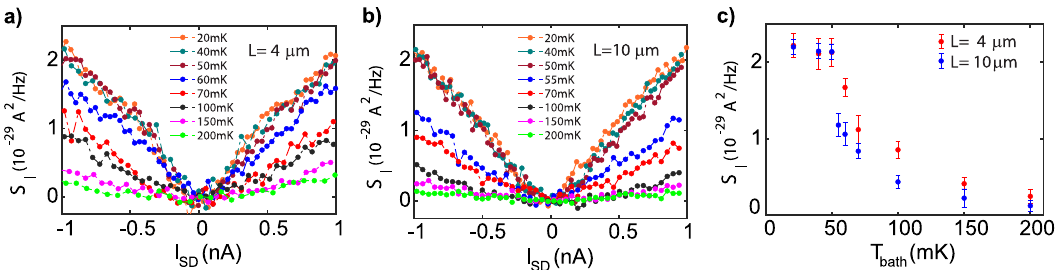
Fig. 3 Temperature dependence of the noise. a and b show the noise along the upstream direction at ν = 2/3, at different bath temperatures for L = 4 μ m and L = 10 μ m, respectively. c Noise value at I SD = 1 nA, extracted from the averaged slopes (positive and negative bias) of the linear fi ttings of the noise data (Fig. 3a and b), is plotted as a function of bath temperature for 4 μ m (red circles) and 10 μ m (blue circles) for ν = 2/3. The error bar here is the standard deviation in averaged slope of the linear fi t. The linear fi ttings of the noise data are shown in